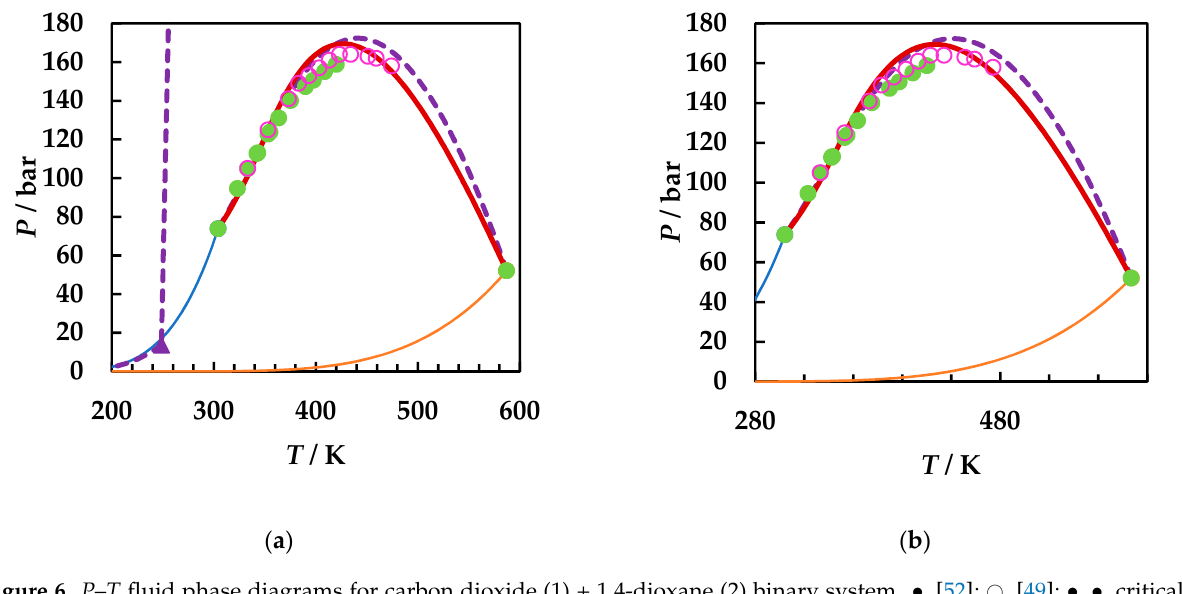
, [49]; • , • , critical (cid:35)